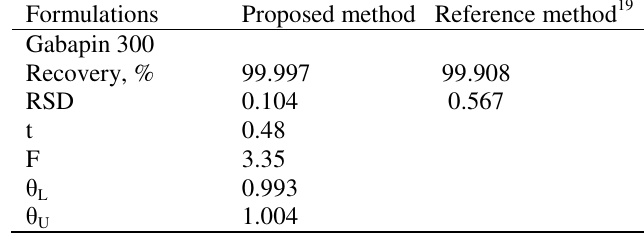
Table 5. Assay results of GBP in commercial capsules using the proposed method and